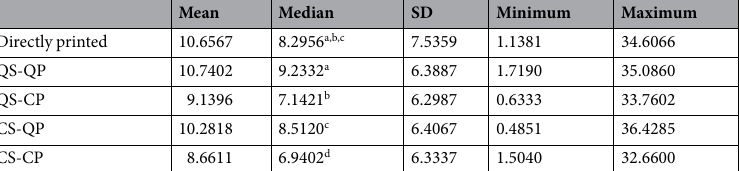
Table 2. Means, SDs, and minima and maxima of ∆ E = standard deviation. ** Different letters in superscript indicate statistically significant differences between groups ( P < 0.005).